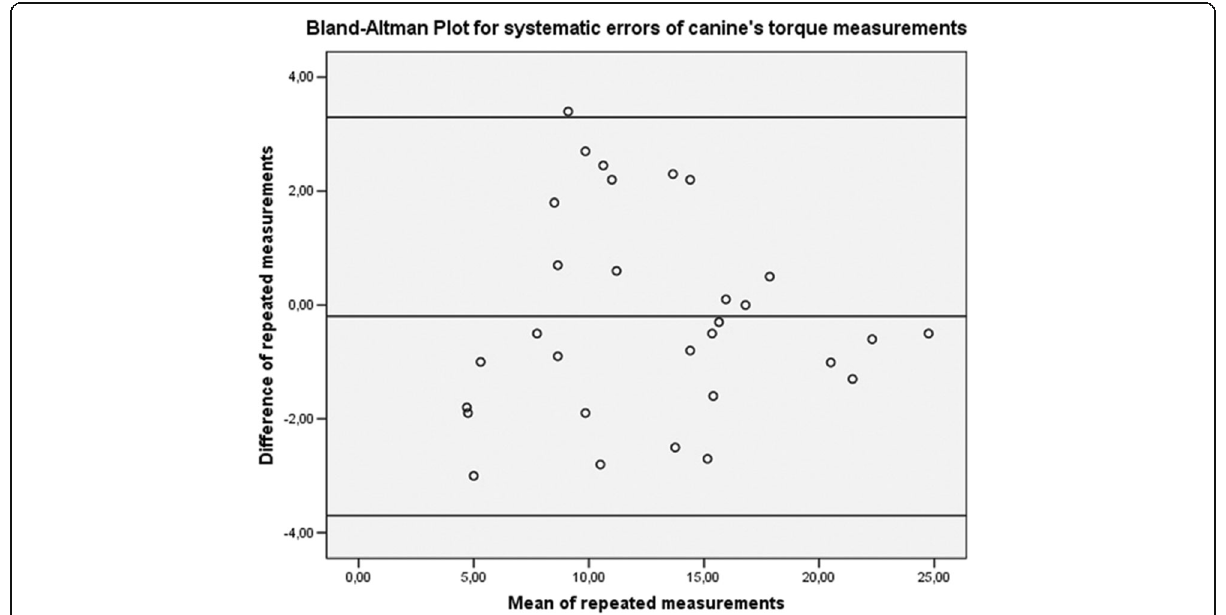
Fig. 4 Bland – Altman plot for repeated measurements of canines, confirming the absence of systematic errors